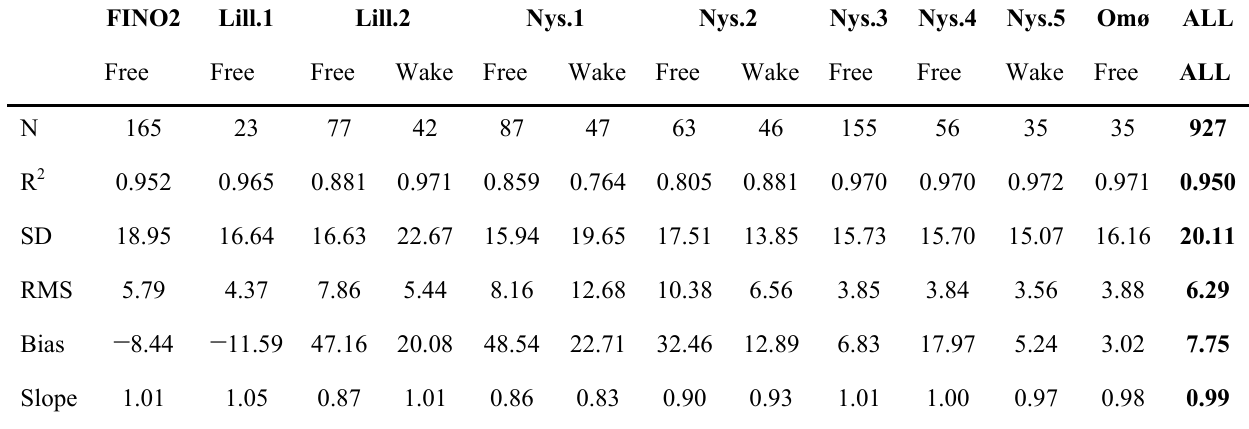
Table 3. Linear regression results for wind direction between masts versus NOGAPS in free stream sectors and wake-influenced sectors; and ALL includes both free stream and wake-influenced sectors; N is number of samples ( − ); R 2 is the correlation coefficient( − ); SD is standard error (°); RMS is root mean square error (°); bias is the offset of the linear regression (°) and the slope ( −